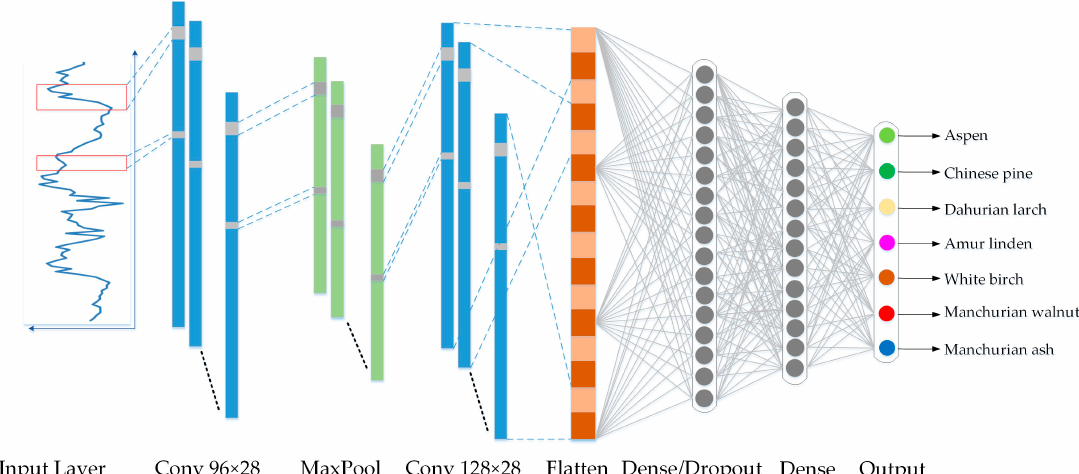
Figure 3. Architecture of the optimal Conv1D-based model.